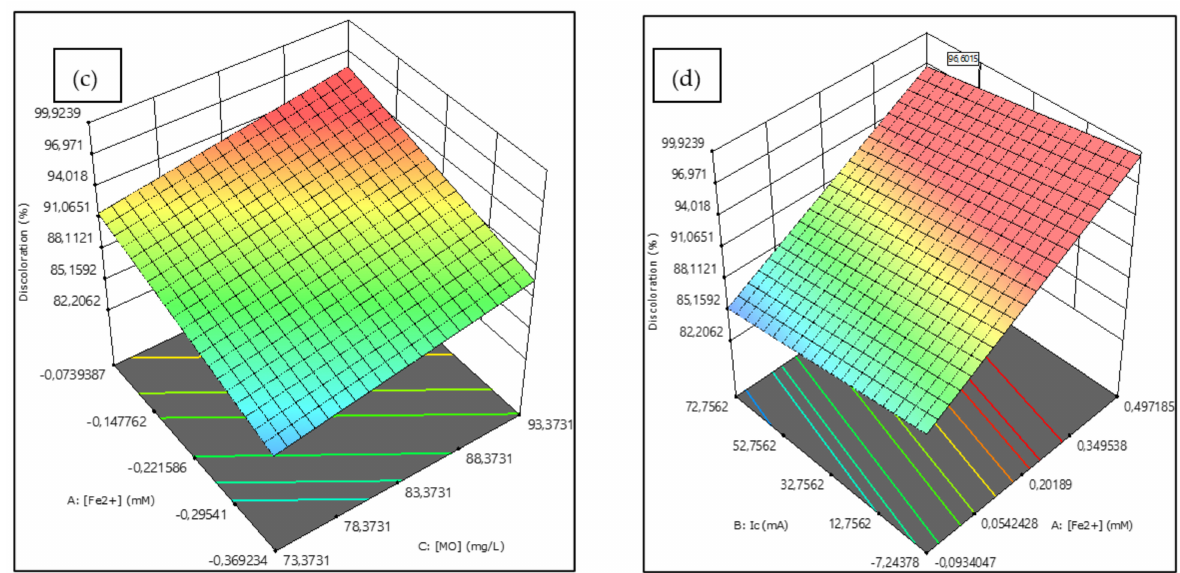
Figure 7. ( a ) Normal probability plot, ( b ) predicted plot versus actual plot, ( c ) 3D surface plot of [Fe 2+ ] versus [MO], and ( d ) 3D surface plot of the effect of Ic versus [Fe 2+ ] on the discoloration response.